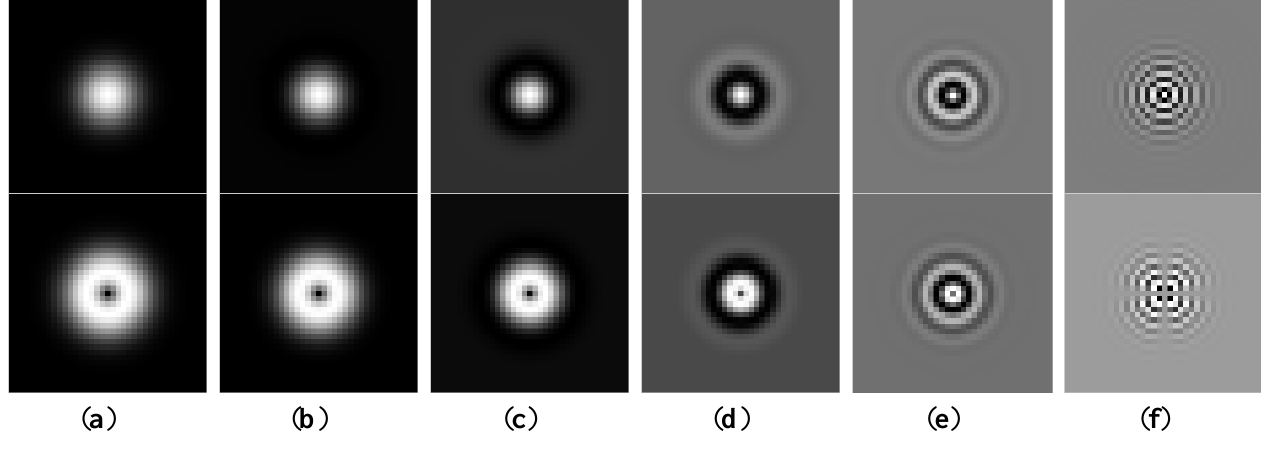
Figure 4. 2-D and 3-D views of the new template Z